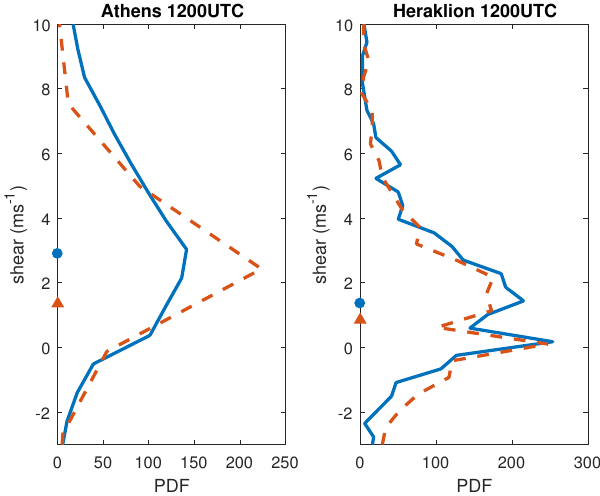
Figure 10. Probability Density Function (PDF) of the wind shear during winter (solid lines) and during summer (dashed lines) estimated from the 1200UTC soundings over Athens (left panel) and Heraklion (right panel) with the PBLH estimated using the gradient method. The median values for the corresponding distributions for the winter (circles) and summer (triangles) months are also